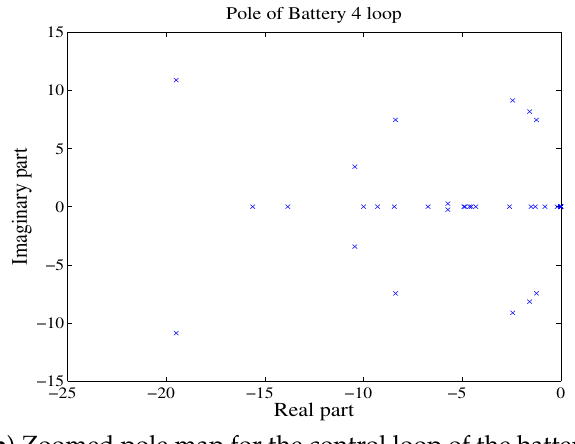
( b ) Zoomed pole map for the control loop of the battery 4 Figure 24. Pole map for the control loop of the battery